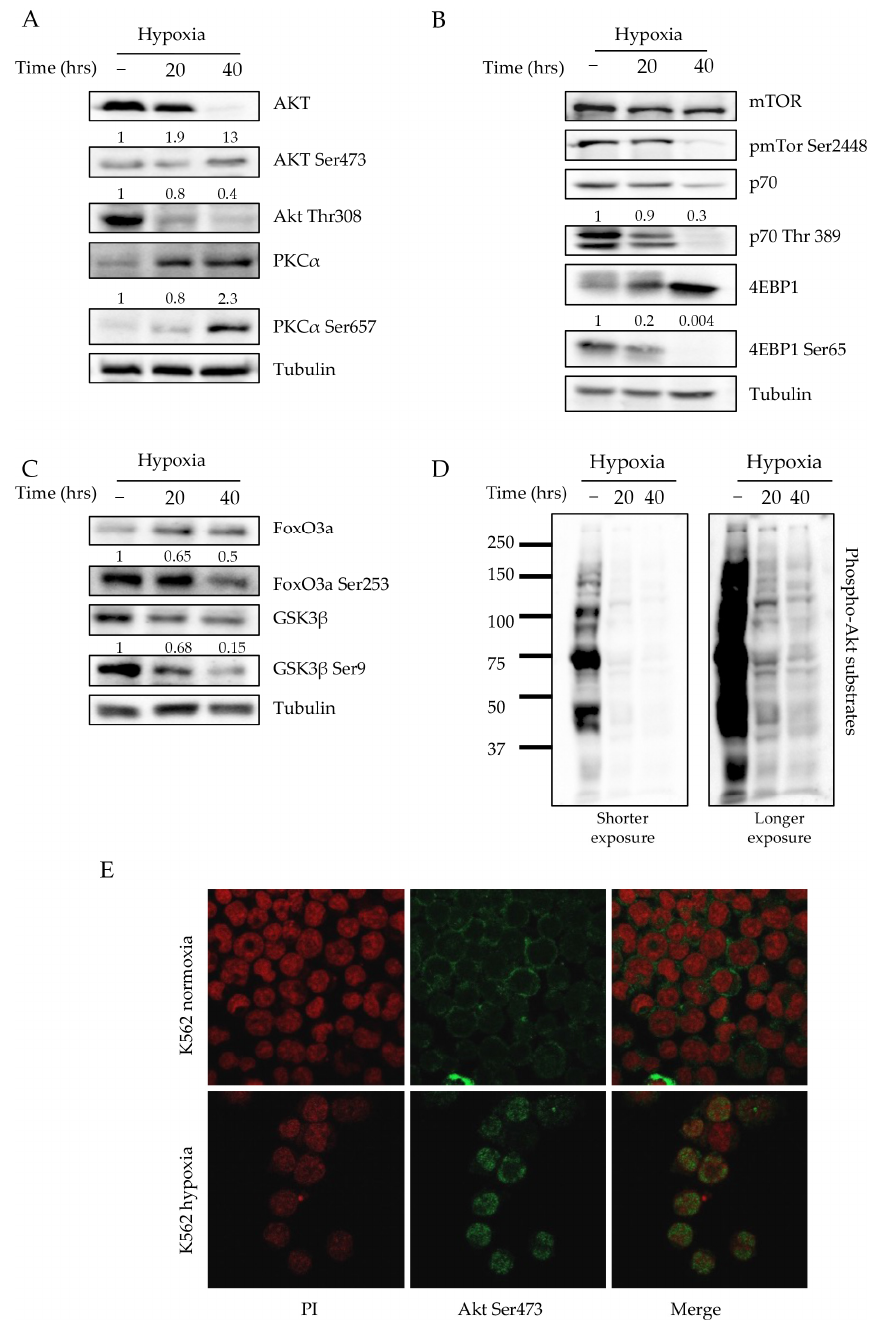
Figure 2. Hypoxia activates mTORC2 signaling and induces phospho-Akt (Ser473) nuclear localization: ( A – C ) Western blot analysis of the main mTORC1, mTORC2 and Akt kinase substrates. Numbers corresponding to normalization are expressed as fold changes compared to normoxic specimen. ( D ) Western blot analysis performed on K562 total cell lysates under normoxic and hypoxic condition by using a specific antibody to recognize the phospho-Akt-substrate consensus motif (R-X-R-X-X-S/T). Shorter and longer exposure were included to highlight the different patterns between our conditions. ( E ) Immunofluorescence of phospho-Akt (Ser473) on K562 cells incubated under hypoxic and normoxic conditions. Significant green nuclear staining corresponding to phospho-Akt (Ser473) was observed after low oxygen incubation. Red propidium iodide is used to label nuclei (63× magnification). The reduction in phospho-Foxo3a and phospho-Gsk3 β observed after the hypoxia treatment suggests that low oxygen conditions activate these stem-related proteins and